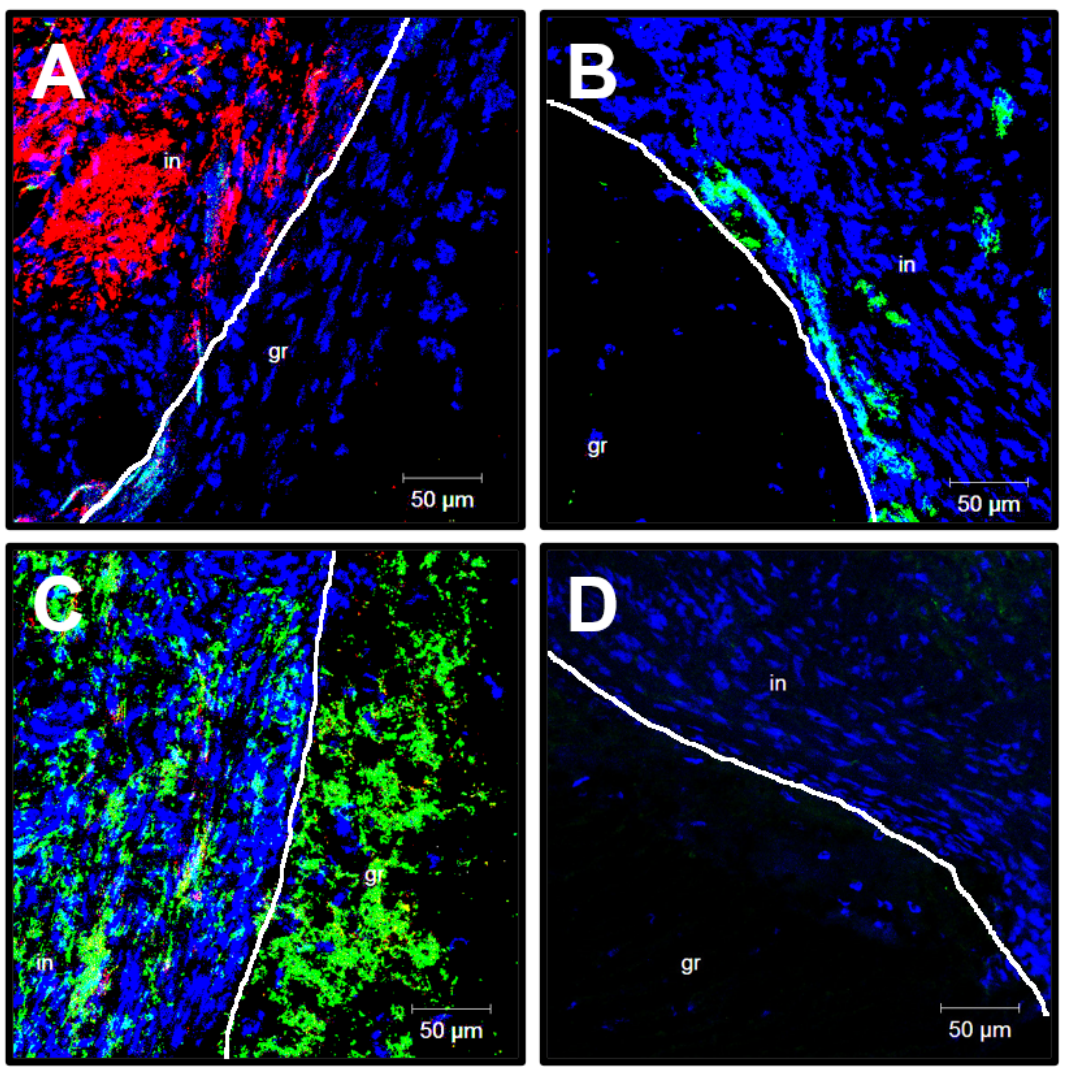
Figure 9. Confocal microscopy examination of ePTFE vascular prostheses 6 months postimplantation. ( A ) CD31 (a marker of endothelial cells, green colour) and α -SMA (a marker of VSMCs, red colour) staining; ( B ) von Willebrand staining (a marker of endothelial cells and a component of the subendothelial ECM, green colour); ( C ) Type IV collagen (an ECM protein constituting the basement membrane, green colour) and type I collagen (an ECM protein characteristic of the adventitia, red colour) staining; ( D ) Type III collagen staining (an ECM protein constituting the basement membrane and tunica media, green colour). DAPI counterstaining (nuclei, blue colour). White line demarcates the graft (gr) from thrombotic masses (in). Representative images, ×200 magnification.